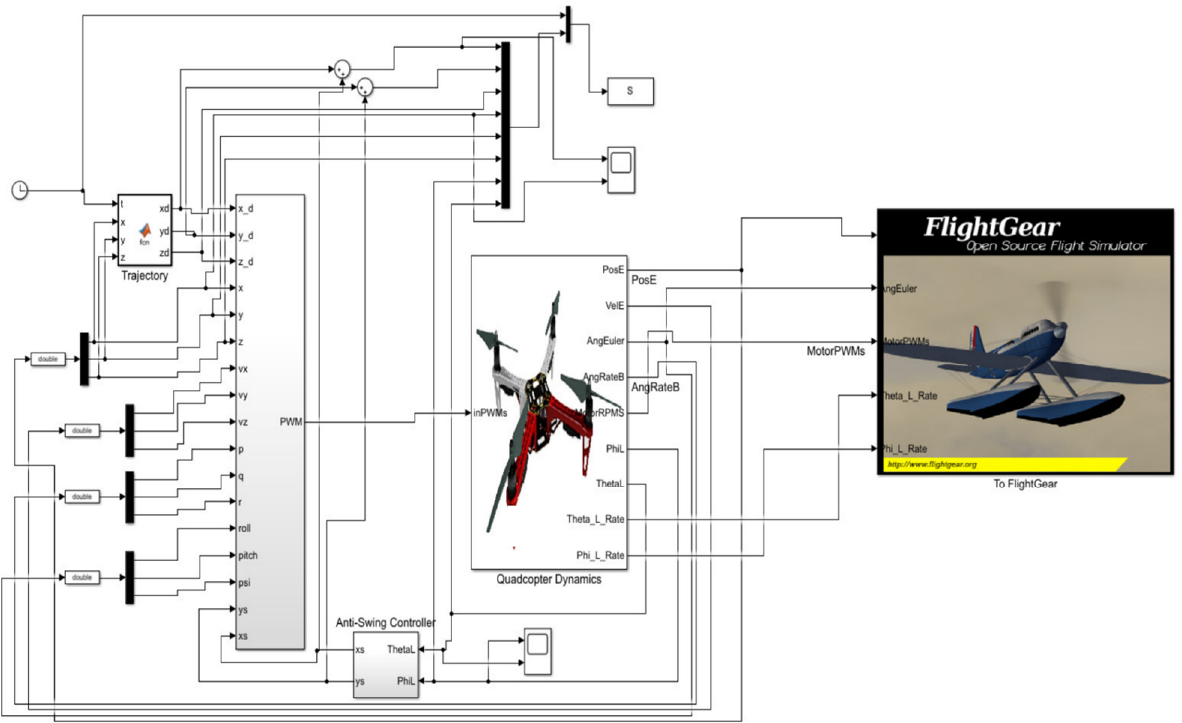
Figure 24. Simulink model of the anti-swing control system .